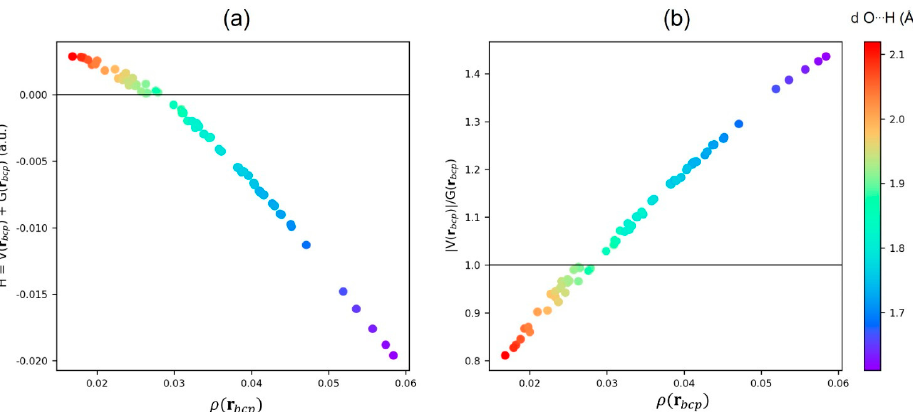
Figure 5. ( a ) Relationship between 𝐻(𝐫 𝑩𝑪𝑷 ) (a.u.) with the HB 𝜌(𝐫 𝑩𝑪𝑷 ) (a.u) and ( b ) Relationship between |𝑉(𝐫 𝑩𝑪𝑷 )|/𝐺(𝐫 𝑩𝑪𝑷 ) (a.u.) with the HB 𝜌(𝐫 𝑩𝑪𝑷 ) (a.u). The color scale it related to the intera- tomic distance O a ···H.